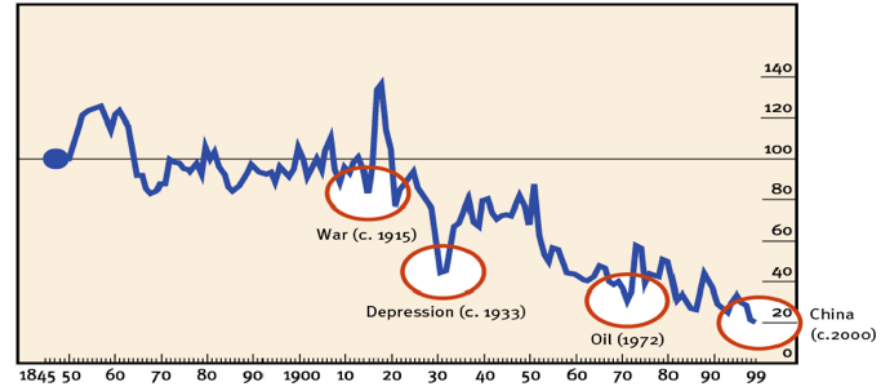
Figure 1 . The Economist industrial commodity-price index, in real dollar terms, 1845–1850 = 100. This is a narrow index (51% foods; 49% industrial; no energy) that is rebased as demand changes and as other commodities are included. Oil, omitted from the index, has increased 10-fold since 2000. The four orange ovals marking events (e.g., War, ca . 1915) have been superimposed. Prices doubled on all four occasions